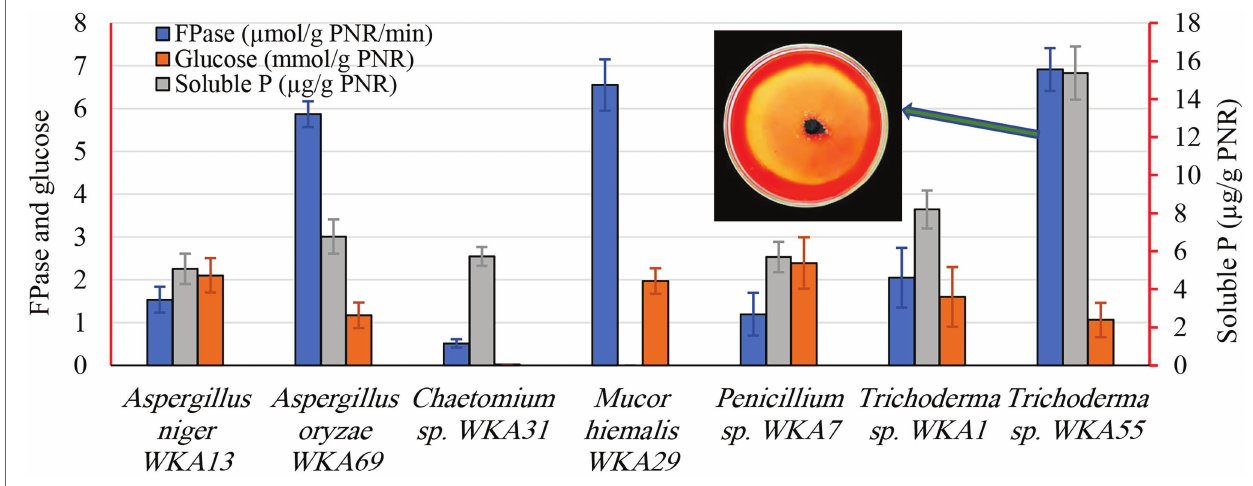
FIGURE 2 | Screening of the endophytic fungi for the cellulase, glucose, and the solubilization of tricalcium phosphate (TCP) after growing on a PNR-based fermentation medium. The figure shows the descriptive assay on the agar plate for detection of cellulolytic activity of Trichoderma sp. WKA55.